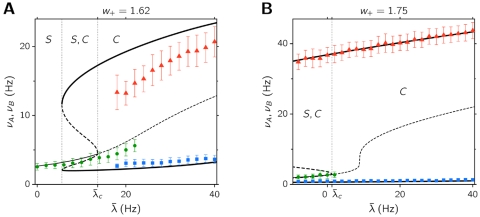
Dependence of the network activity on overall external input, as obtained from the mean field approximation (black solid curves) and from the network simulations (symbols), for w
+ = 1.62 (A) and w
+ = 1.75 (B).Thin solid curve: firing rates of both populations in a stable symmetric state (both populations at equal rates); thick solid curves: _ring rates of the two selective populations in an asymmetric state (one population at high rate, the other at low rate). Thick dashed lines show the position of the unstable fixed point. Dotted vertical lines indicate the boundaries of the three different regimes present in the system, as predicted by the mean field approximation. At λ̅ = λ̅
c the spontaneous state loses its stability. Error bars indicate the sample standard deviation of the firing rates.